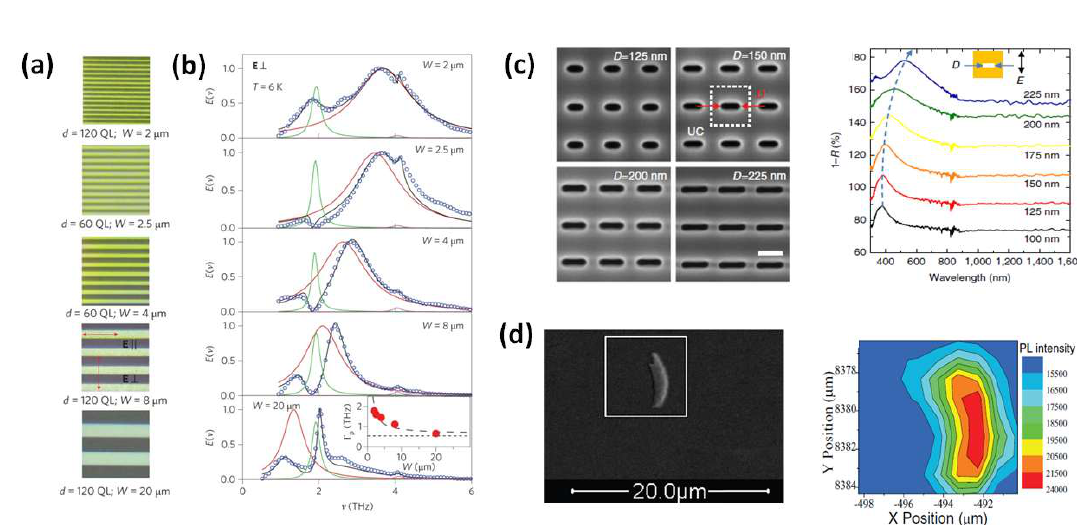
Figure 9: (a) From [197]: False color SEM and (b) corresponding measured extinction spectrum of patterned Bi 2 Se 3 nanoribbons of varying widths. In (b) measured (circles) data are fitted with an analytical model (black lines), enabling the extraction of plasmon (red lines) and phonon (green lines) contributions. The plasmonic resonances occur in the THz regime and are found to scale quadratically with ribbon width, as expected for a 2DEG on the surface of a topological insulator. (c) From [196]: SEM image and measured spectrum of a patterned Bi 1.5 Sb 0.5 Te 1.8 Se 1.2 material at significantly smaller size scales. Evidence pointing to plasmonic response in the UV (<400 nm) is observed. (d) From [195]: SEM image of a Bi 2 Te 3 film on a ZnO substrate, which exhibits photoluminescence near the bandgap energy in the UV spec- trum. The boxed are indicates the region where the photoluminescence measurements are collected. Enhanced intensities are observed in the spatial region corresponding to the flake location. This is attributed to plasmonic excitations within the film as a result of being over- laid on the rough substrate. Reprinted with permission from Refs [197], [196] respectively. Copyright 2013, 2014 Nature Publishing Group.